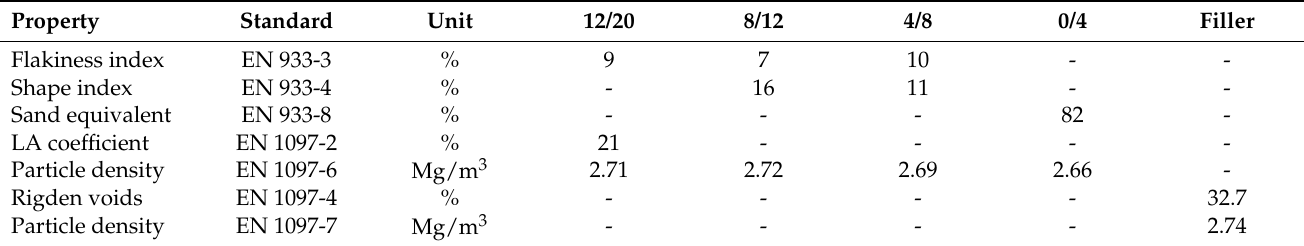
Table 2. The physical properties of the selected limestone aggregates.